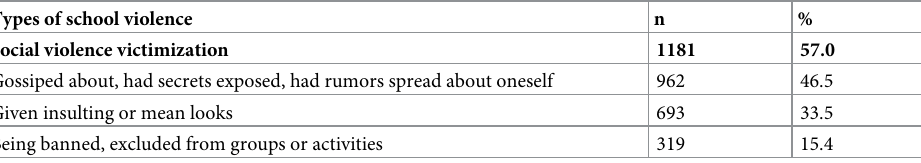
Table 2. Frequency and types of of social violence (N =